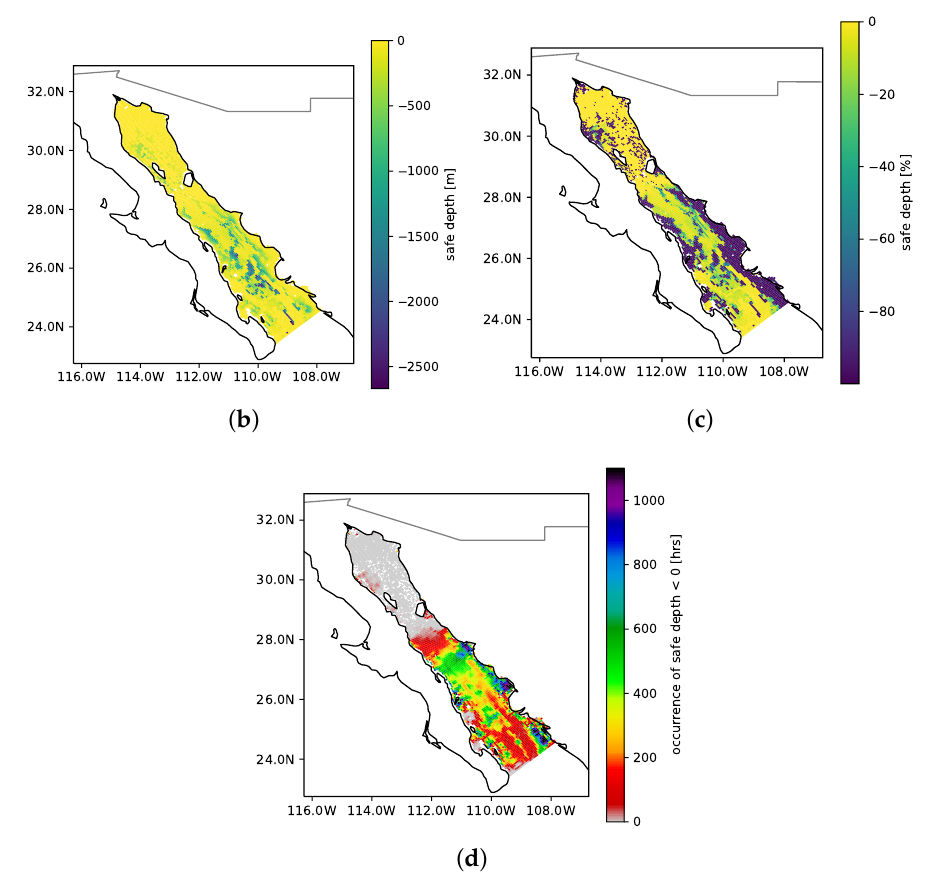
Figure 19. Safe depth analysis over the course of Hurricane Odile. ( a ) Safe depth in meters. ( b ) Percent of total depth, indicating locations where the anomaly extends through the whole water